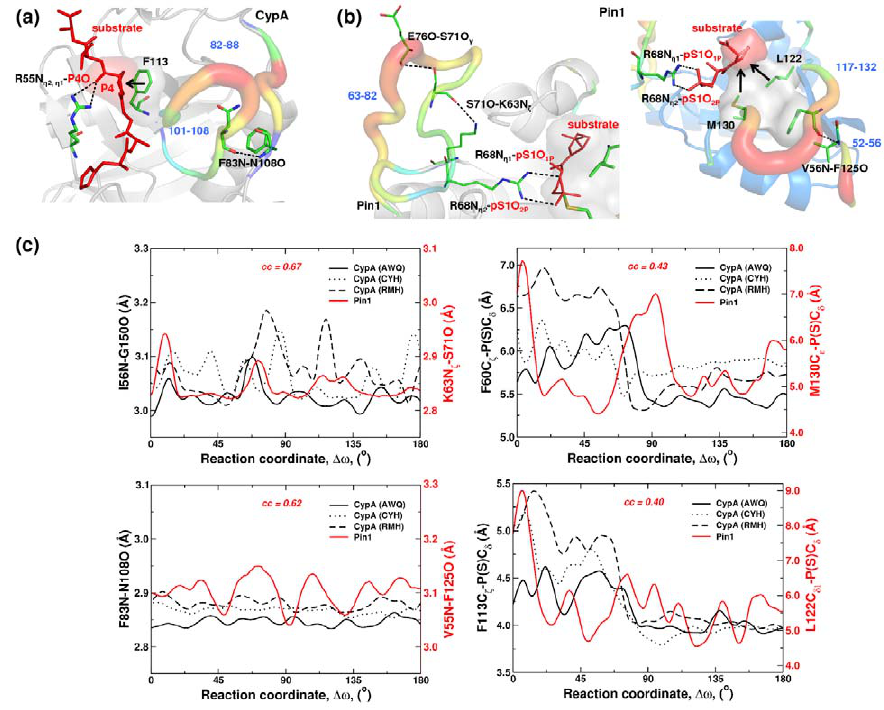
Figure 2. Comparison of reaction-coupled flexibility in non-homologous PPIases. PPIases CypA and Pin1 with dissimilar structural folds catalyze the isomerization of peptidyl-prolyl peptide bonds. (a) In CypA, the flexible surface regions 82–88 and 102–108, connected by F83N–N108O, impact the residue substrate preceding the target proline (F113 as well as N102 and A103) and region flexible region 57–60 is connected to substrate network residue R55. (b) In Pin1 flexible surface regions 52–56 and 117–132 are interconnected by V56N–F125O relay motions into the active-site through hydrophobic residues L122 and M130. On the other face of Pin1 the flexible surface regions 63–82 are also connected by network hydrogen bond to R68 that forms hydrophilic interactions with substrate similar to R55 of CypA. (c) Similarity in the behavior of distal (I56N-G150O/K63N f -S71O and F83N-N108O/V55N-F125O) as well as active-site interactions (F60C f -P(S)C d /M130C e -P(S)C d and F113C f -P(S)C d /L122C d 1 -P(S)C d ) for CypA and Pin1. Equivalent network surface network hydrogen bonds impact the enzyme–substrate interactions in the active-site. Note, cc values indicate correlation coefficients between CypA (AWQ) and Pin1 interactions calculated over the course of reaction profile. See ref. [25] for further details.